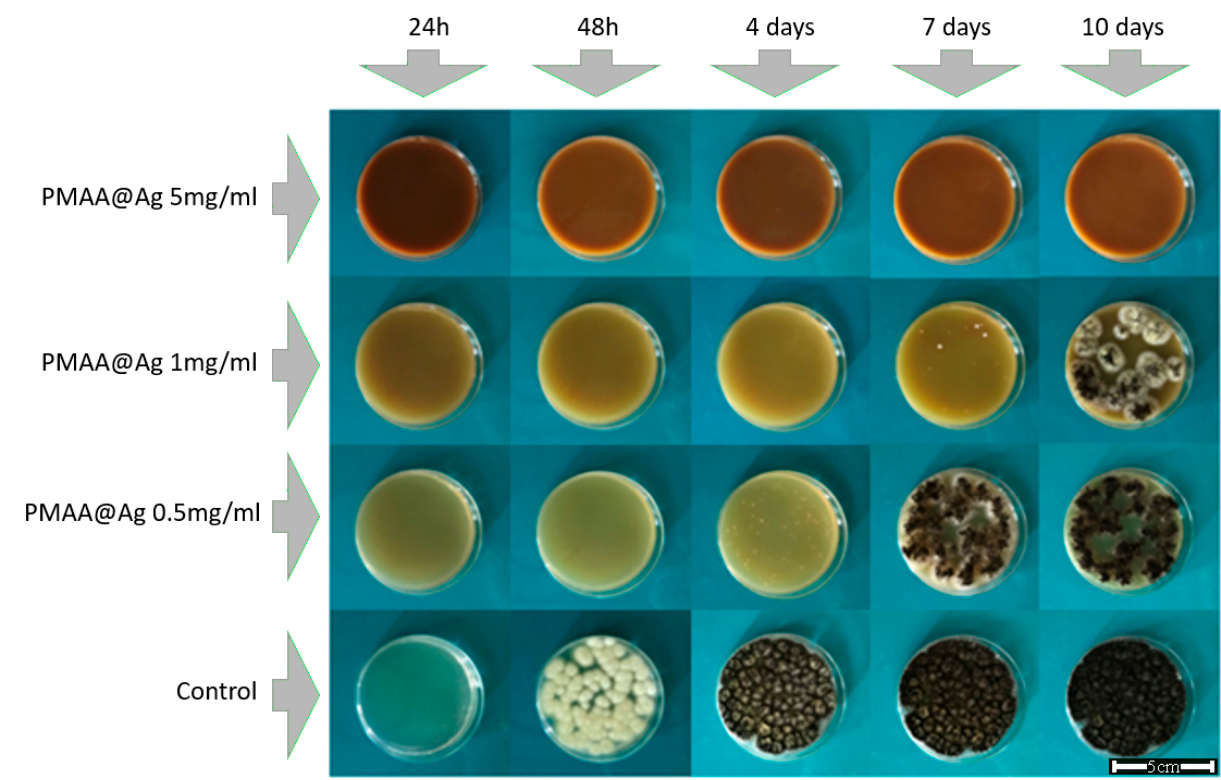
Figure 8. Antifungal activity exerted by different concentrations of PMAA@Ag (5 mg/mL, 1 mg/mL, 0.5 mg/mL) against Aspergillus niger after 24 h, 48 h, 4 days, 7 days, and 10 days of incubation.